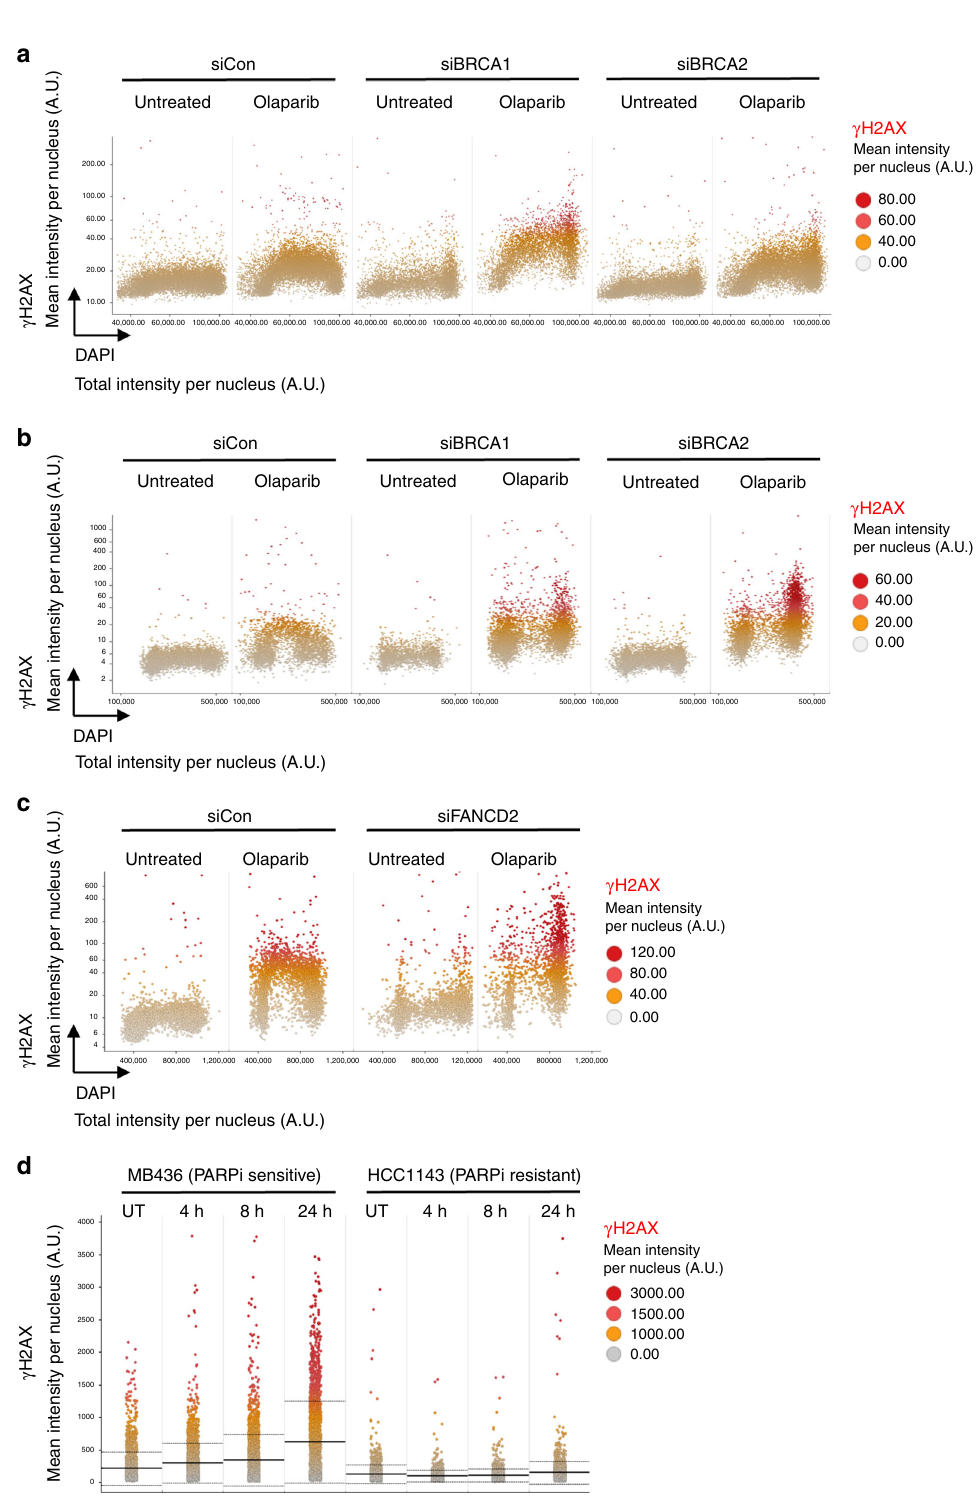
Fig. 2 Defects in HR factors confer hypersensitivity to PARPi. a U-2 OS cells were transfected with negative control siRNA or siRNAs against BRCA1 or BRCA2, treated with 10 μ M olaparib for 16 h, and stained for γ H2AX and DNA content. b Cells were transfected as in a and treated as indicated with 10 μ M olaparib for 48 h. Cell cycle resolved γ H2AX pro fi les are shown. c Cells were transfected with negative control siRNA or siRNA against FANCD2, treated as indicated with 10 μ M olaparib for 48 h, and cell cycle resolved γ H2AX pro fi les are shown. d MDA-MB436 and HCC1143 cells were treated with 10 μ M olaparib as indicated and stained for γ H2AX. Horizontal lines represent population averages ± s.d. Color codes as de fi ned in the fi gure